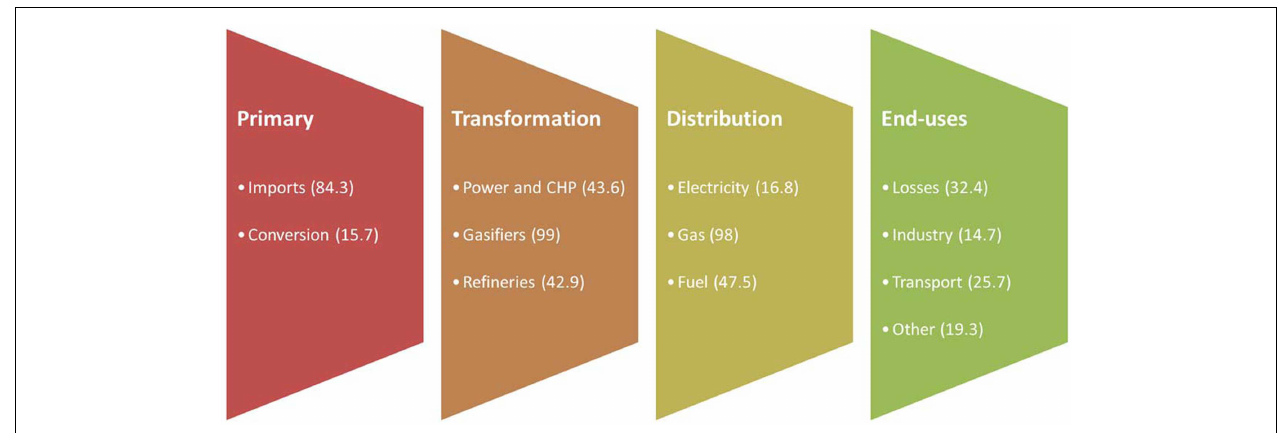
FIGURE 1 | Energy primary, transformation, distribution, and end-uses in Spain for year 2011 (values as percentage) . Adapted from Danesin et al. (2012). Renewable energies are included in the conversion